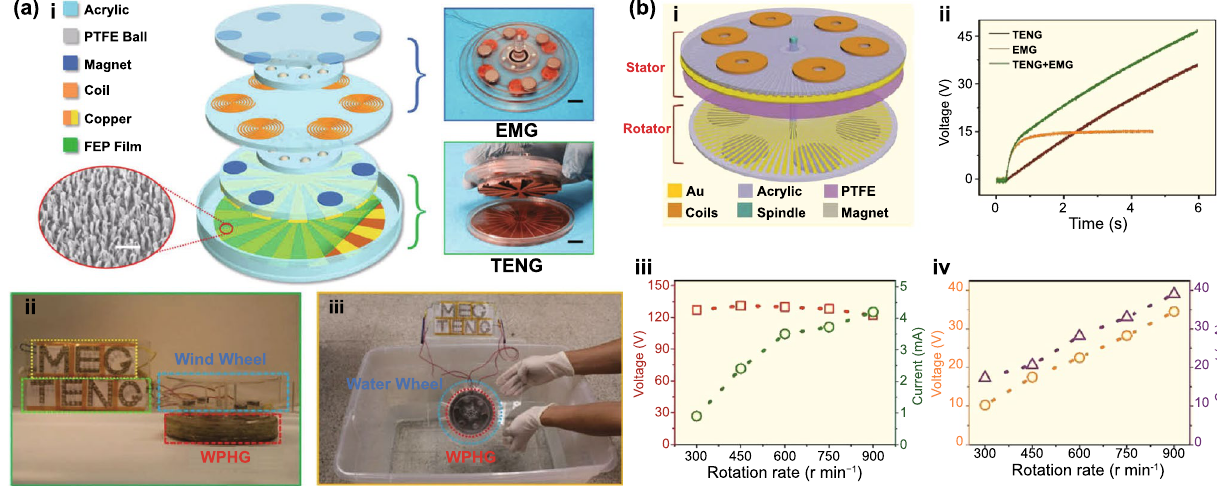
Fig. 10 a (i) Structure design of the waterproof hybrid E-TENG generator fabricated by Guo et al. (ii) Demonstration of the generator for harvesting wind energy under simulated rainy condition. (iii) Generator used for harvesting water flow energy under water. Reproduced with permission from Ref. [65]. Copyright permissions from 2016, Advanced Energy Materials. b (i) Diagram of the rotating-disk-based hybridized nanogenerator designed by Chen et al. (ii) Charging performances of the TENG, EMG and hybridized nanogenerator for a 470 μF capacitor. Variation of the output OC voltage and SC current with the rotation rate for the (iii) TENG and (iv) EMG. Adapted from Ref. [66]. (Color figure